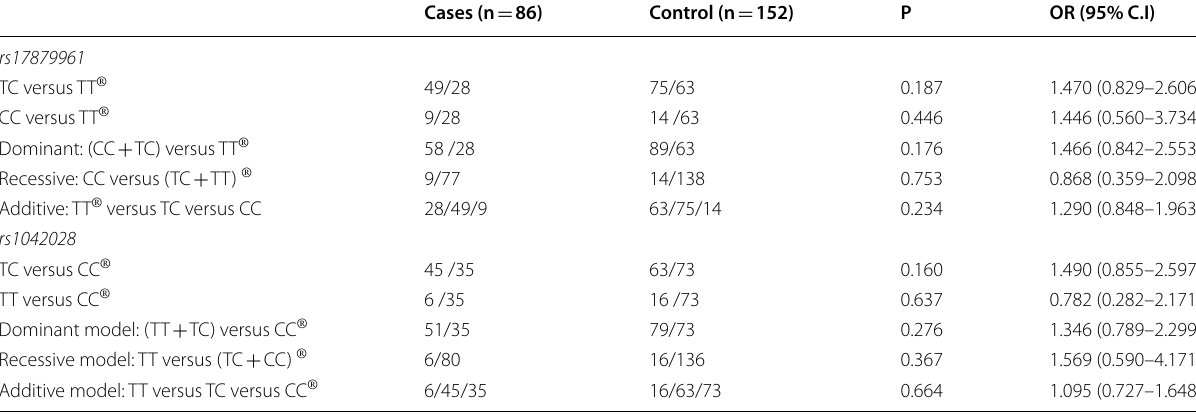
Table 5 Association between rs17879961 and rs1042028 polymorphisms and CRC risk